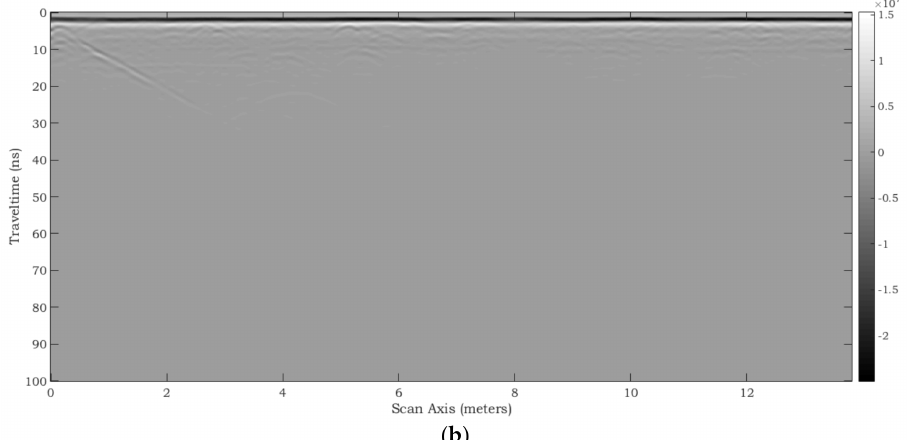
Figure 25. Profiles recorded in the limestone region by using GPR 1, on acquisition line 2, with antennas operating at: ( a ) 270 MHz; ( b ) 350 MHz.